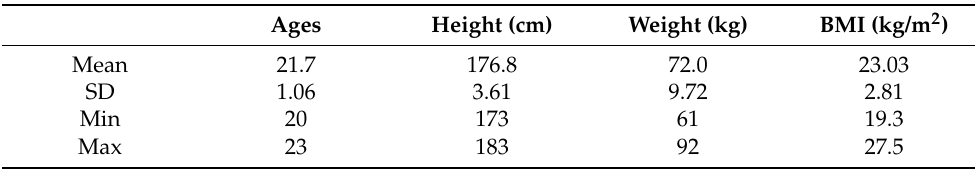
Table 1. General characteristics of the